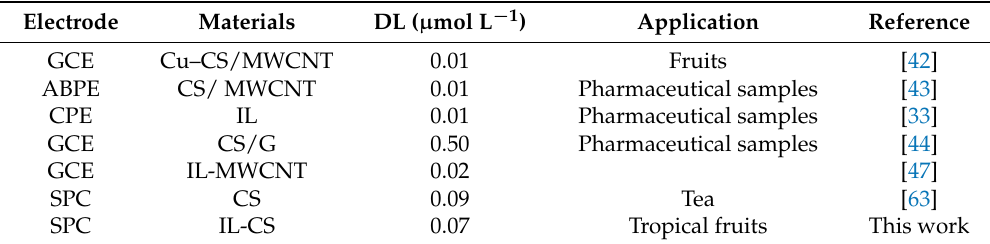
Table 1. Modified electrodes for rutin determination.